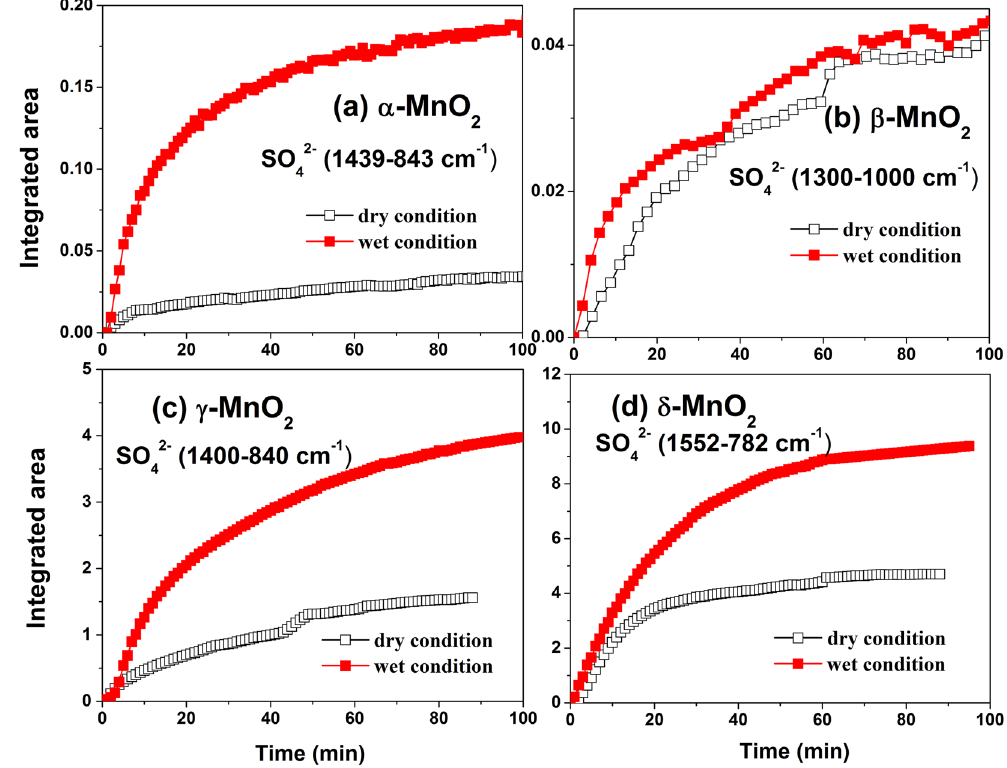
Figure 9. Comparison of integrated areas for the sulfate species formed on different crystal manganese oxides between dry and 40% RH conditions. α -MnO 2 (1439–843 cm − 1 ), β -MnO 2 (1317–1112 cm − 1 ), γ -MnO 2 (1400– 840 cm − 1 ) and δ -MnO 2 (1552–782 cm − 1